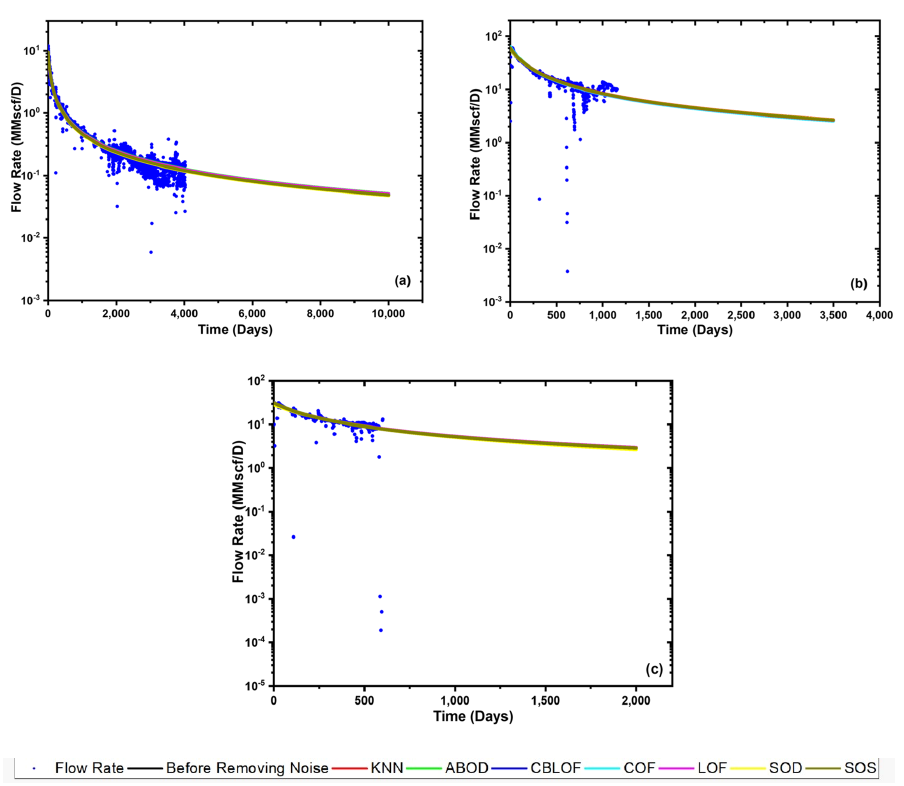
Figure 19. Applying Arps decline model before and after removing noise using the seven OD al ‐ gorithms for; ( a ) Well_12, ( b ) Well_29, and ( c ) Well_40.